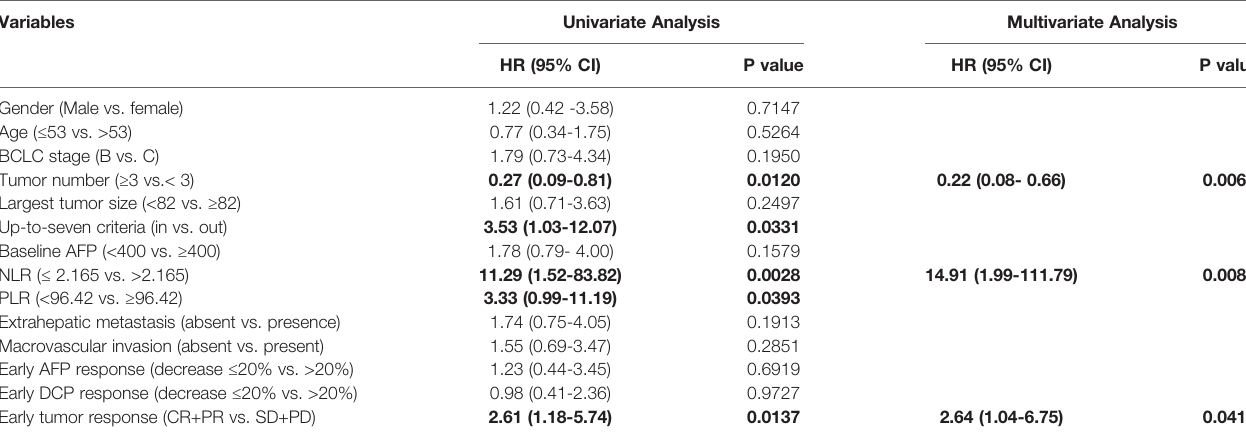
TABLE 4 | Multivariable Cox regression analysis for overall survival. Variables